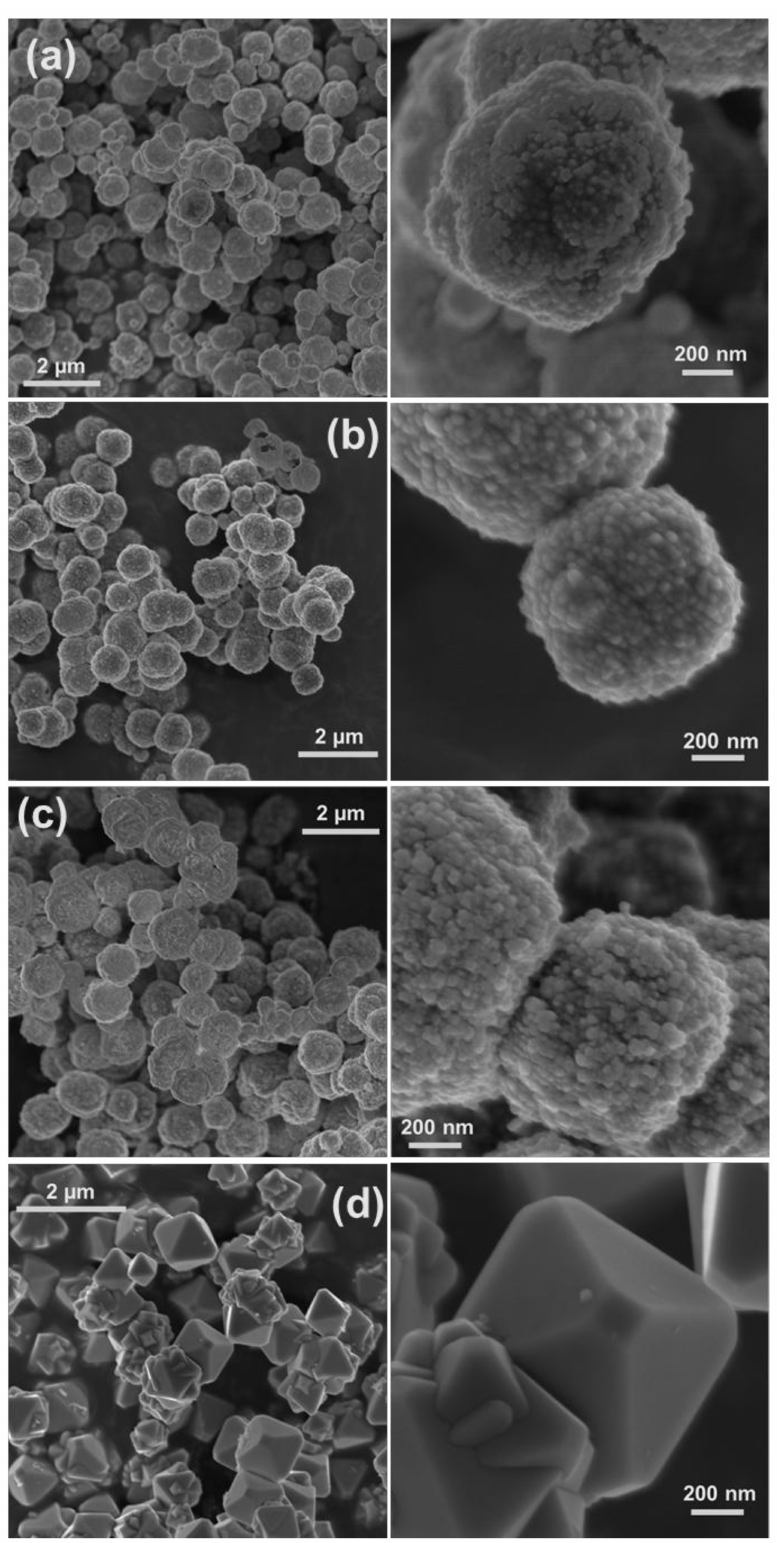
Figure 3. HR-SEM images of synthesized materials in 0.01 M Cu(II)—0.01 M EDTA solutions containing ( a ) 0.01 M CTAB; ( b ) 0.01 M DoTAC; ( c ) 0.01 M SDS; and ( d ) 0.01 M DDAO. The images show the polycrystalline structure of spherical copper NPs of 600–900 nm, synthesized in solutions ( a – c ) and octahedral cuprous oxide NPs of 500–900 nm, formed in solution ( d ). The images on the right-hand side are of synthesized materials ( a–d ) at higher